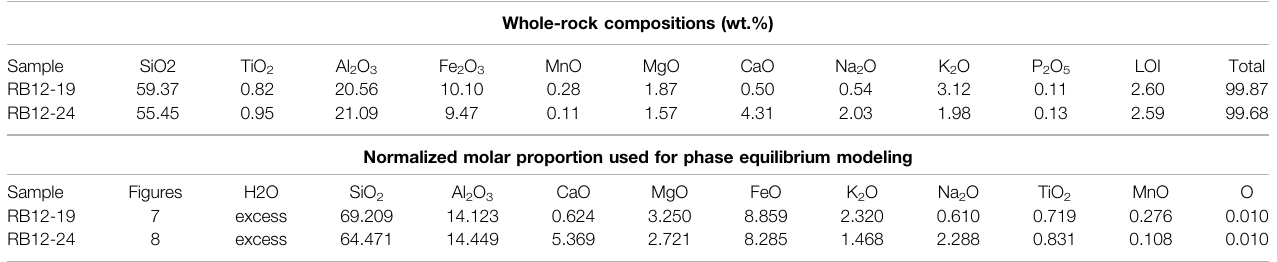
TABLE 1 | Bulk compositions used for phase equilibrium modeling.